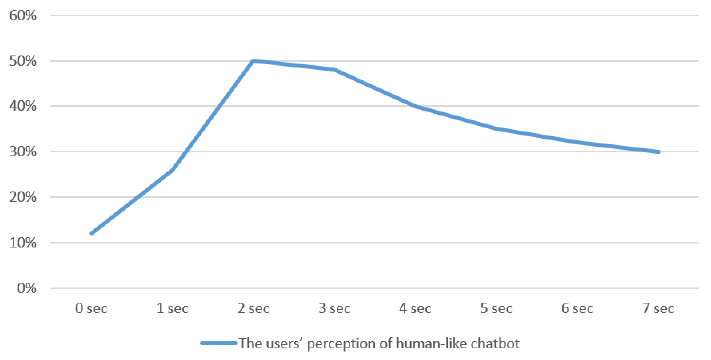
Figure 5. The users’ perception of human-like